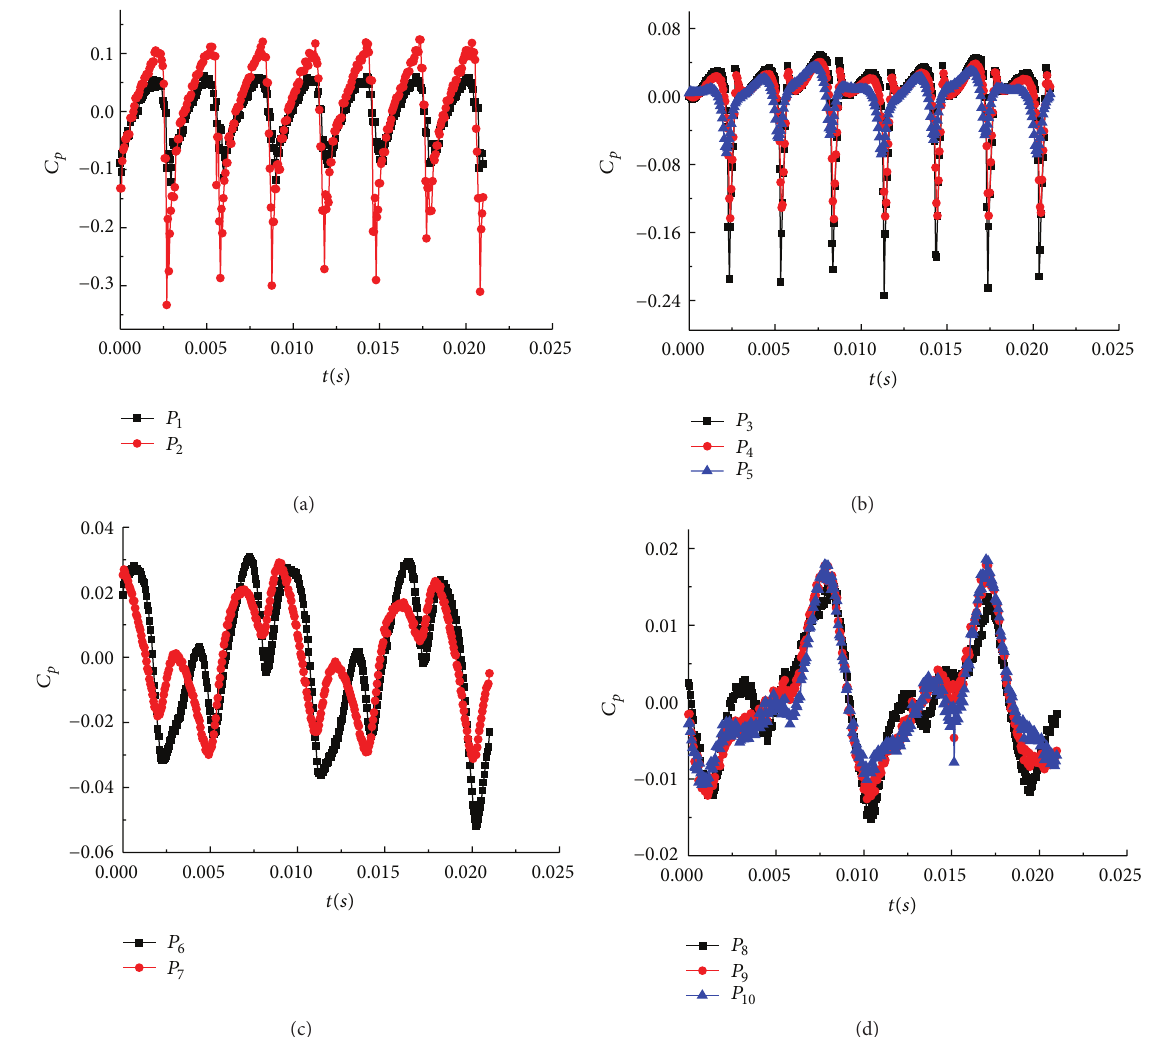
Figure 10: Pressure fluctuation at different locations: (a) impeller leading edge, (b) impeller trailing edge, (c) RGV leading edge, and (d) within